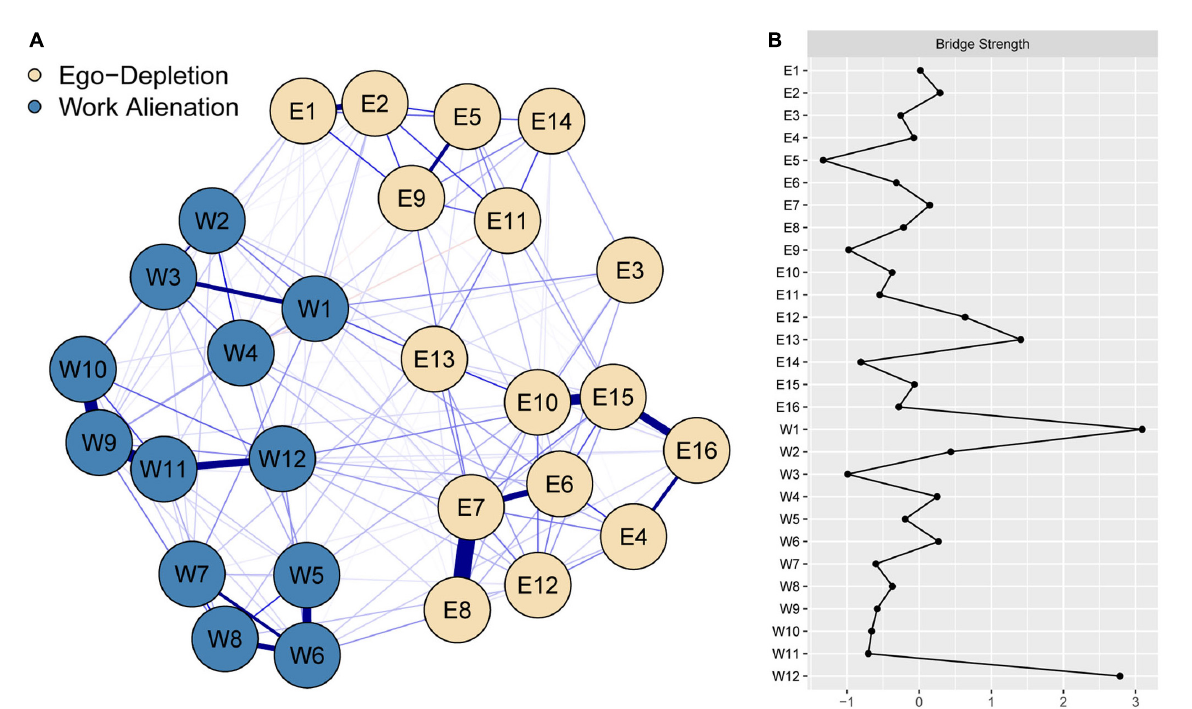
FIGURE1 Psychological network of ego depletion and work alienation items. (A) The blue line represents positive partial correlation while the red line represents negative partial correlation. The thicker the line and the more saturated the color, the larger the partial correlation coefficient. (B) Bridge Strength ( z score ) of Ego depletion and Work Alienation Items. Network. E1, I feel full of energy; E2, It is easy for me to set goals; E3, I find it difficult to exercise as much as I should; E4, I have urges to hit, throw, break, or smash things; E5, I have no trouble making decisions; E6, I experience repeated unpleasant thoughts; E7, I get upset easily; E8, I try not to talk or think about things that bother me; E9, I handle stress well; E10, I experience uncontrollable temper outbursts; E11, I can easily keep up with my friendships and relationships; E12, I cry easily; E13, I have difficulties remembering things; E14, I find it easy to stick to a healthy diet; E15, I feel moody; E16, I have urges to beat, injure, or harm someone; W1, Sometimes I do not know what to do with the work instructions from my superiors; W2, Promotion is a slim hope for me; W3, At